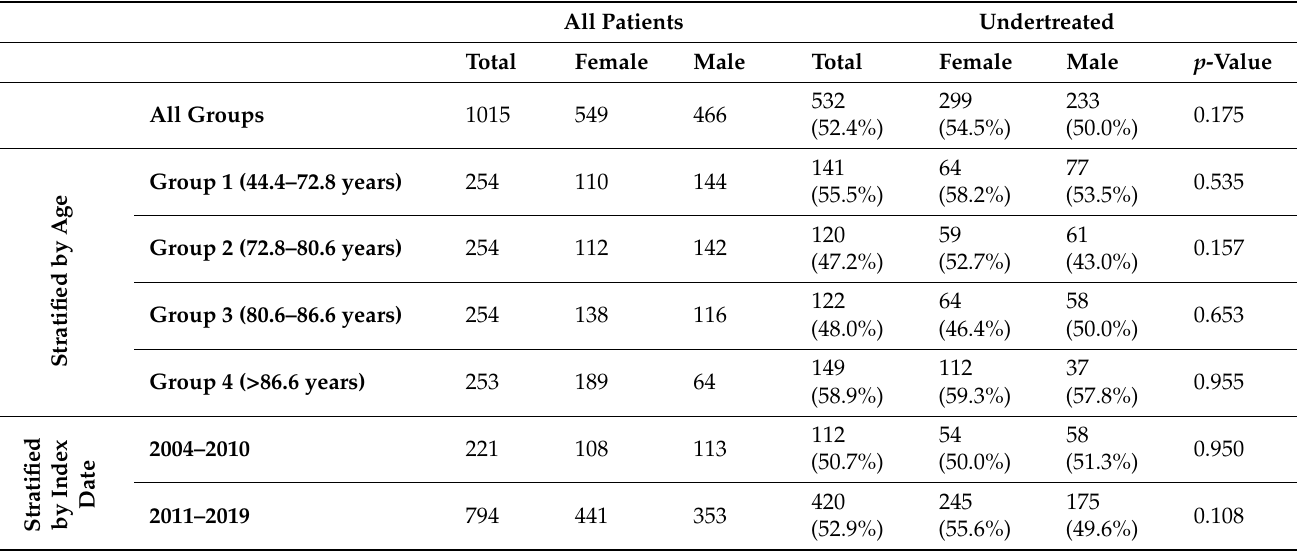
Table 2. Anticoagulant undertreatment rates for patients with a CHA 2 DS 2 -VASc score ≥ 2 stratified by age groups and index stroke